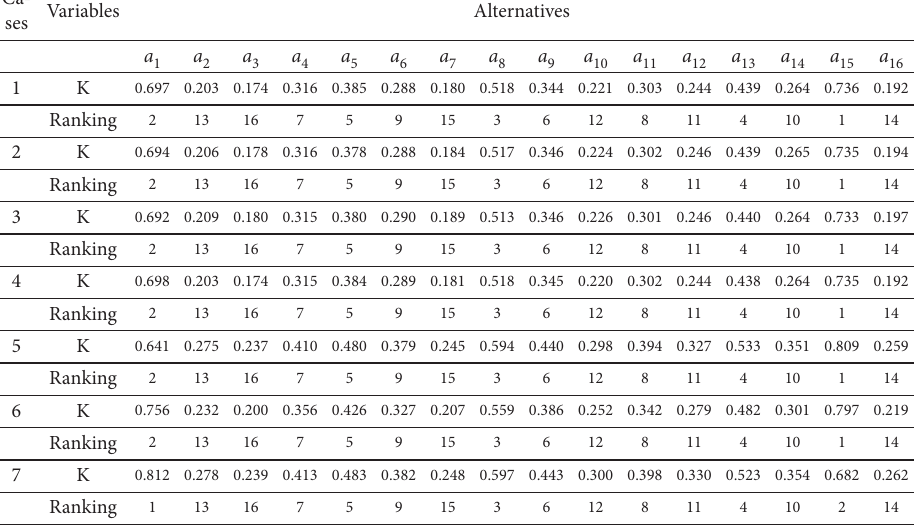
Table 14. The sensitivity analysis results Ca- ses